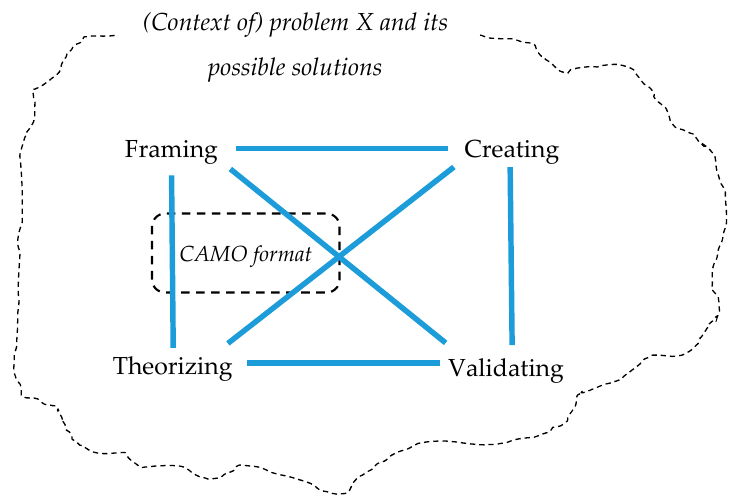
Figure 1. Framing, theorizing, creating and validating in design science, including the role of CAMO knowledge.